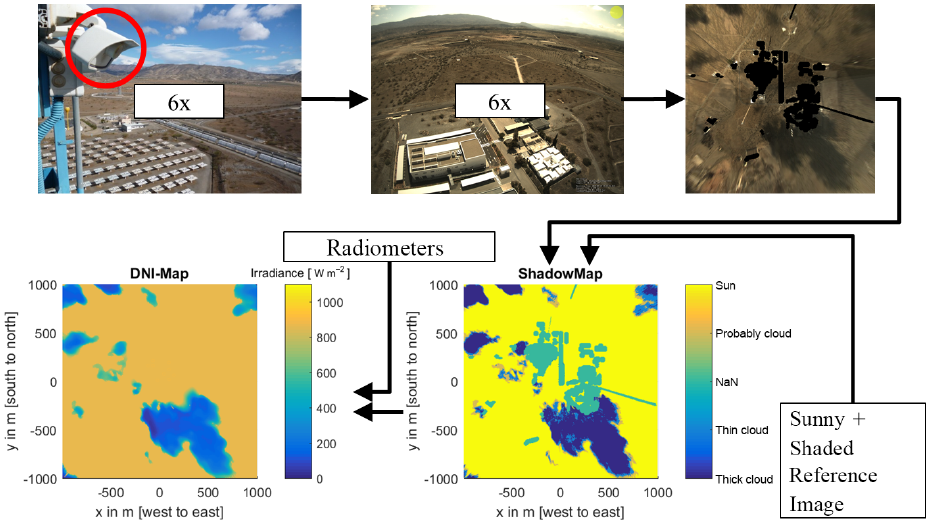
Figure 1. Working principle of the shadow camera system. Downward-facing cameras are used to generate spatially resolved irradiance (DNI, GHI, GTI) maps.